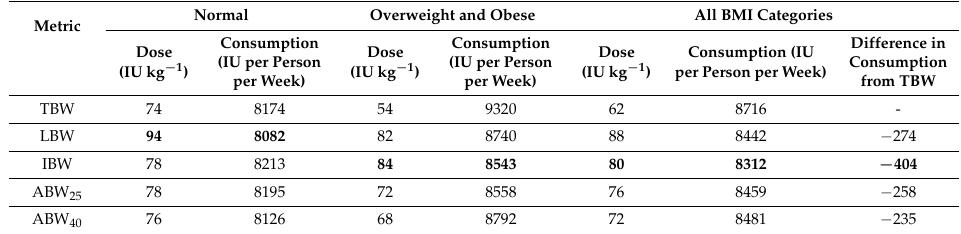
Table 4. Summary of safety and economic evaluations of different weight metrics used in